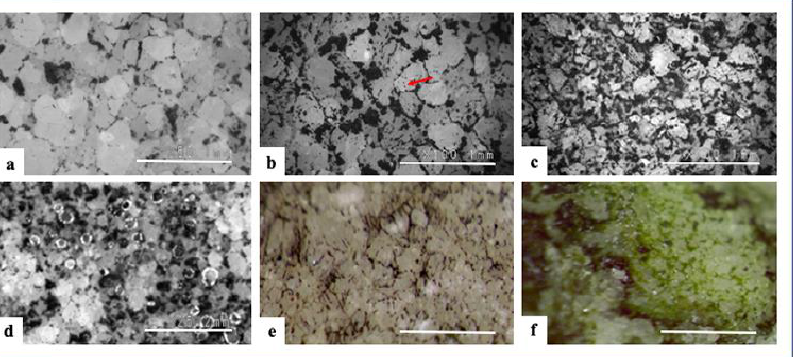
Figure 2. Microscopic observation of the surface of the SMFC external white marbles: ( a – d ) in situ observations; ( e , f ) ex situ observations of marble fragments. ( a , b ) Microbial colonization around the marble grains at the SE ( a ) and NW sites ( b ), little black spots presumably composed of black fungi (arrow) are visible over the marble grains in ( b ). ( c ) Colonization by a more developed biofilm forming a patina over the marble at the NW site. ( d ) Thalli of the lichen Myriolecis dispersa growing preferentially on biofilm black spots at the SE site. ( e ) Growth around grains resembling that of cyanobacteria on a marble sample. ( f ) Growth of algae and dark colonies on a marble sample. The scale bar is 1 mm in ( a – f ) and 2 mm in ( d